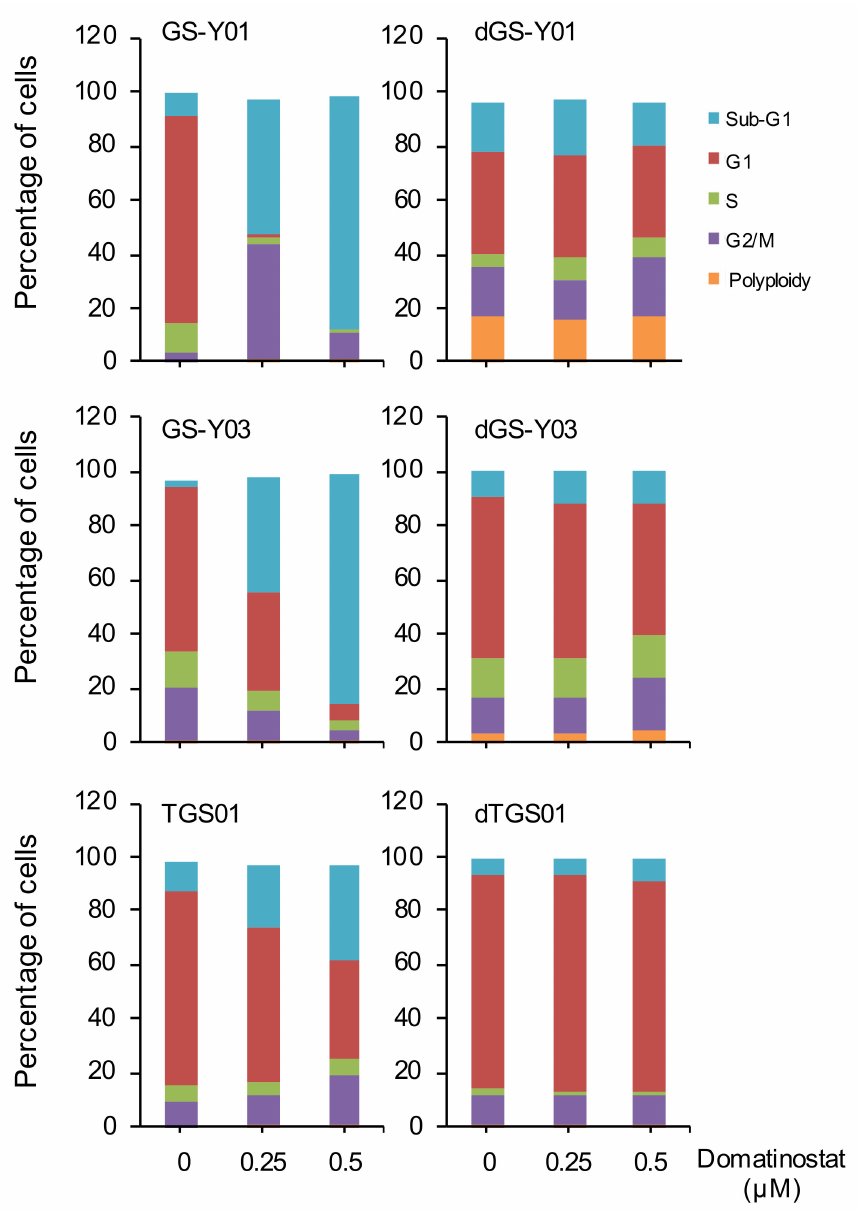
Figure 2. Effect of domatinostat on the cell-cycle distribution of glioma stem cell lines and their differentiated counterparts. GS-Y01, GS-Y03, TGS01, and their differentiated counterparts (dGS-Y01, dGS-Y03, and dTGS01) treated with the indicated concentrations of domatinostat for 3 days were subjected to flow cytometric analysis of cellular DNA content by propidium iodide staining. Results from a representative experiment repeated in two independent biological replicates with similar results are